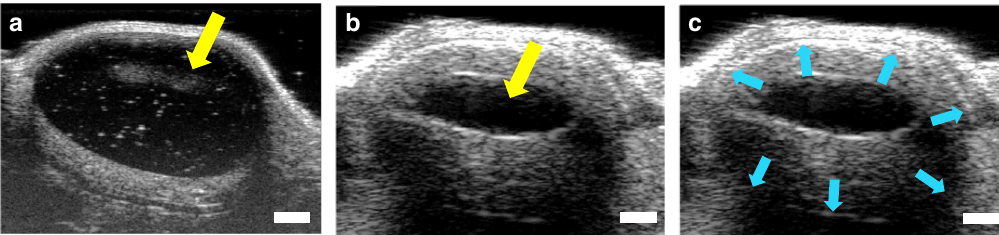
Fig. 5 Ultrasound (US) images of the ISFI after subcutaneous injection. ISFI formulation containing 1:2 w/w PLGA/NMP was injected (65 µ L) s.c. into nude (nu/nu) mice ( n = 7) and imaged using volumetric ultrasound. Images illustrate 2D slices from one plane through the same subcutaneous implant volume at days 0 and 2 ( a , b , respectively). The black center region (yellow arrow) indicates the portion of the implant remaining in the liquid state (presumably, NMP solvent), which decreased after initial injection. c is the same implant as b , except with green arrows delineating the outer implant boundary, indicated by a fi ne grayscale demarcation in the ultrasound image. Volume measurements were obtained by a reader who measured the approximate implant dimensions on two orthogonal image planes, resulting in length, width and depth measurements to estimate ellipsoid volume (volume of the liquid core was not separately quanti fi ed in this study). Scale bars indicate 1 mm